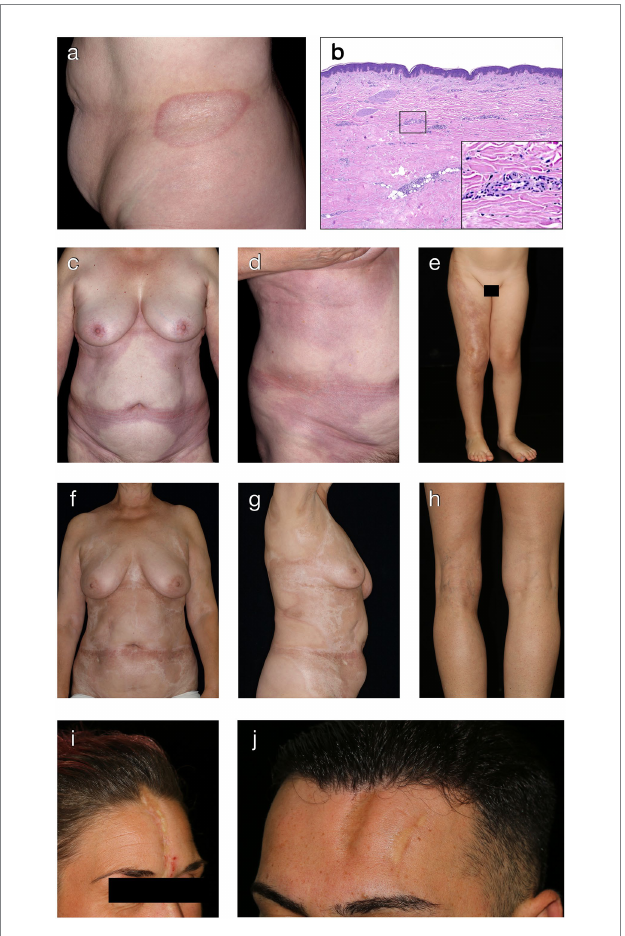
FIGURE 2 Clinical and histological hallmarks of morphea. (A) Well-defined oval patch with a central ivory white area surrounded by an erythematous violaceous rim (“lilac ring”) in a patient with plaque-type morphea. (B) The histology from a cutaneous biopsy from a sclerotic morphea lesion typically showing a thin epidermis, basal keratinocytes displaying pigment, scarce lymphocytic inflammatory infiltrates in the papillary dermis and around the vessels, with significant sclerosis in the reticular dermis and atrophy of the adnexal structures (H&E staining, 40×). Magnification displaying minimal periadnexal lymphocytic inflammatory infiltrates in the papillary dermis and thick, hyalinized, eosinophilic collagen bundles in the reticular dermis with entrapped atrophic adnexal structures (H&E staining, 200×). (C,D) Extensive, well- demarcated, coalescing erythematous violaceous patches on the trunk indicative of an early, inflammatory stage of generalized morphea. (E) Band-like, atrophic, hyperpigmented plaque in a blaschko-linear distribution in a child with linear morphea of the limb. (F,G) Ill-defined, coalescing, pink erythematous patches with important central sclerosis in a patient with generalized morphea, sclerotic disease stage. (H) Atrophy of the underlying tissue with asymmetry of the limbs in a patient with deep morphea. (I,J) Median and paramedian linear depressed, sclerotic plaques of morphea en coup de sabre with the presence of cicatricial